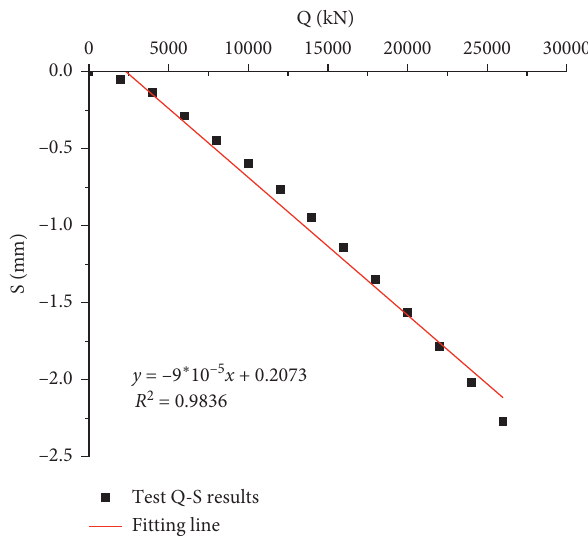
Figure 14: Linear fitting of static stiffness for the cap-pile system. Table 3: K d / K s of the cap-pile system or single pile at different frequencies. Tested cap-pile system or single pile